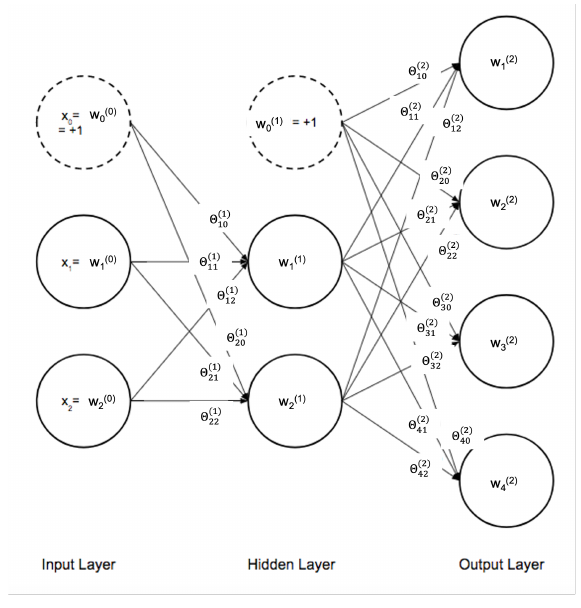
Figure 7. Neural Network